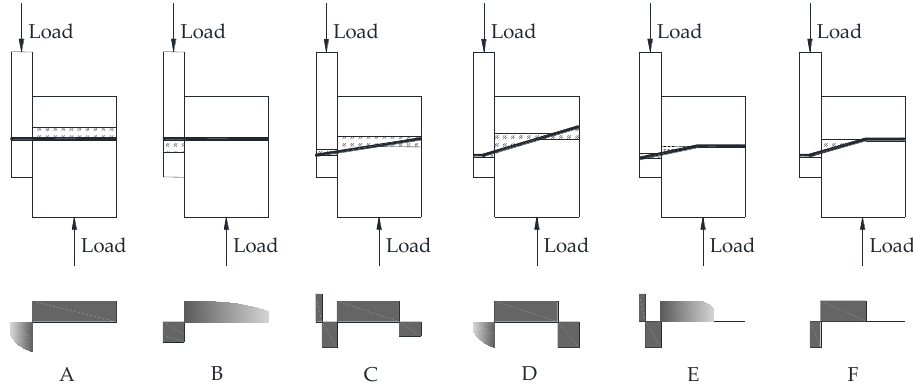
Figure 3. Failure modes for sheathing-to-framing joints in design codes.